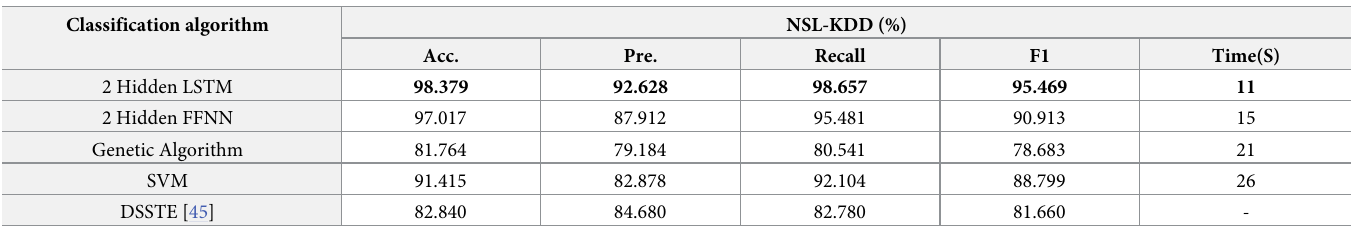
Table 6. NSL-KDD Comparison results among different classifiers.